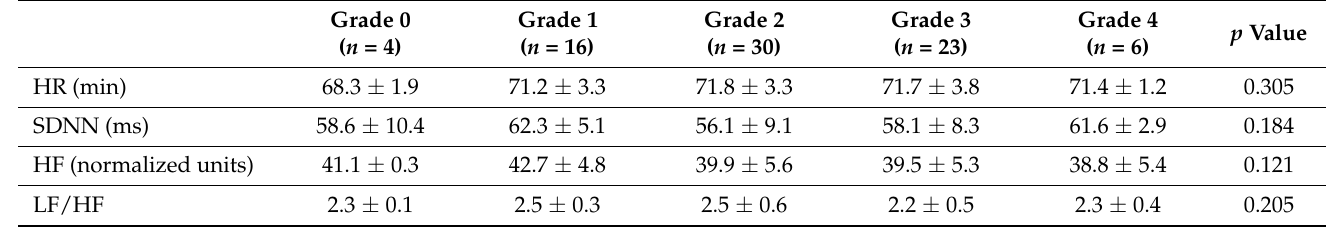
Table 2. HRV Values According to COPD Severity by Spirometric